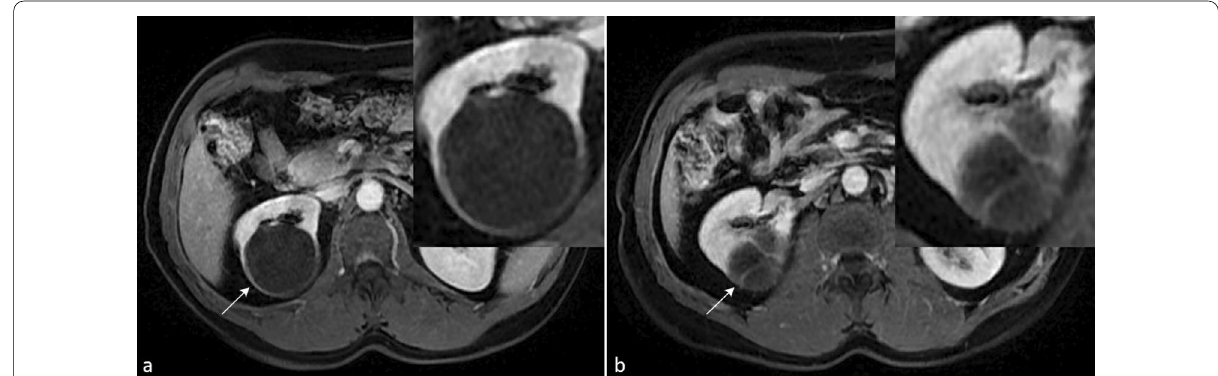
Fig. 1 Right Bosniak IIF cystic renal mass (arrow) at the superior pole of the right kidney. a Axial T1-weighted sequence in portal venous phase showing minimally thickened wall (3 mm). b Axial T1-weighted sequence in portal venous phase shows two of the four thin enhancing septae